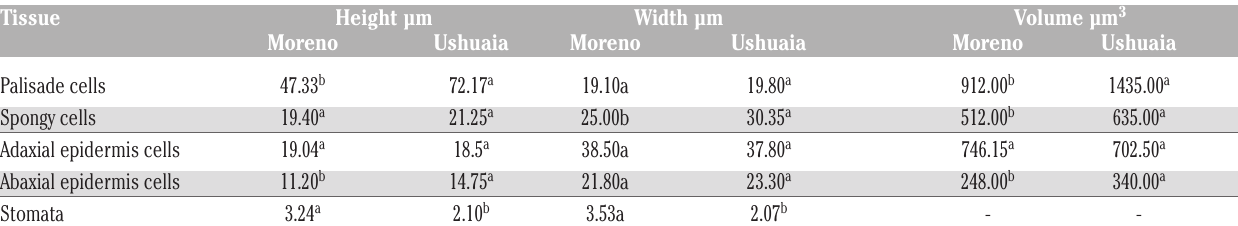
Table 3. Berberis microphylla leaf cell measures studied by light microscopy according to the place of cultivation.